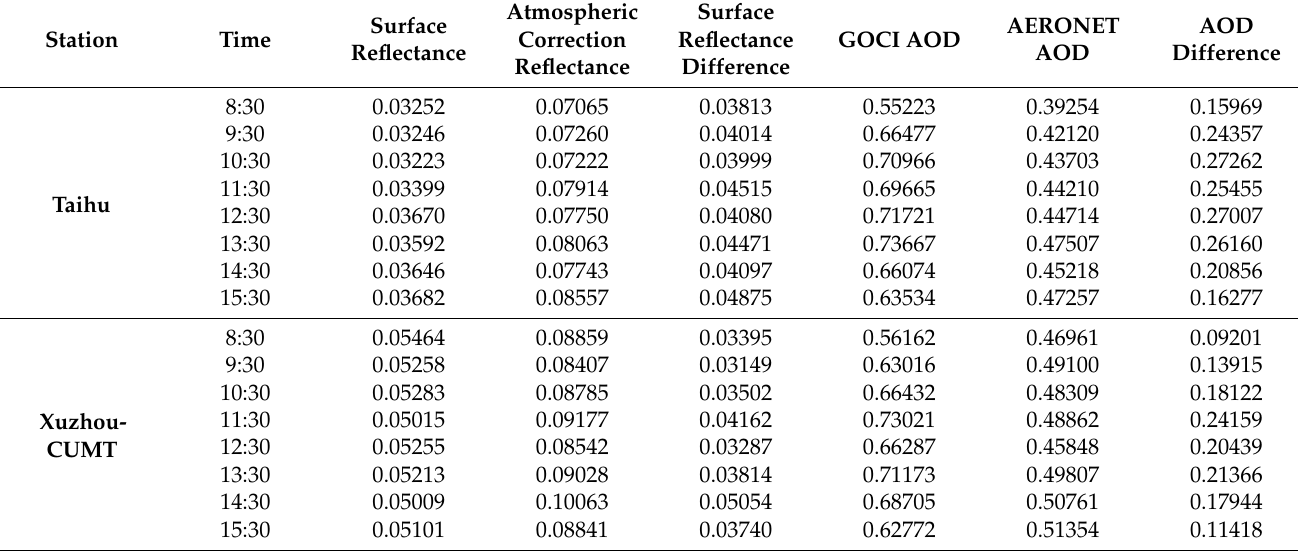
Table 4. Comparison of ground reflectance and AOD with atmospheric correction reflectance and AERONET AOD.